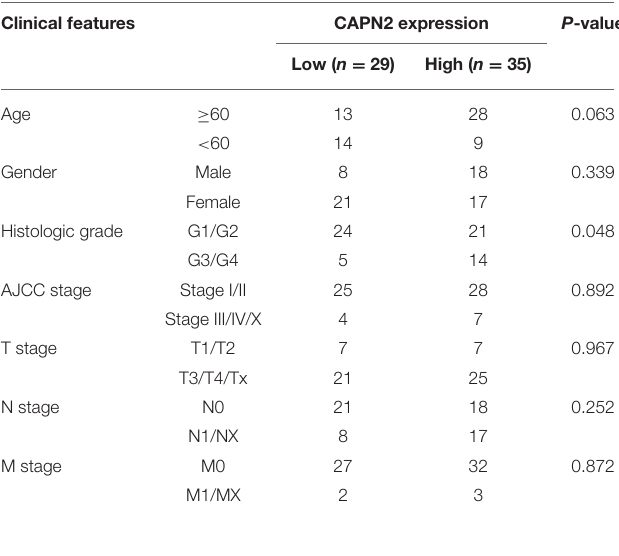
TABLE 1 | Correlation between CAPN2 expression and clinicopathologic features of 64 patients with pancreatic carcinoma. Clinical features